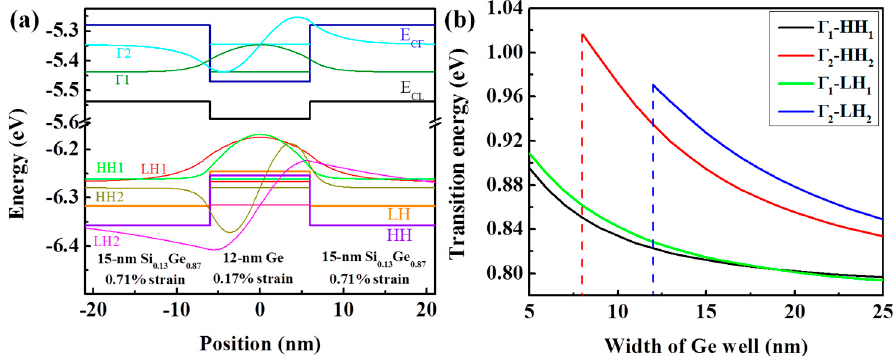
Figure 4. ( a ) Band alignment for a 15-nm Si 0.13 Ge 0.87 /12-nm Ge quantum well and corresponding electronic states; ( b ) Energy variation of Γ 1-HH1, Γ 2-HH2, Γ 1-LH1, and Γ 2-LH2 transitions versus the width of a Ge well. The strain in the Ge well and the SiGe barrier used for calculation is 0.17% and 0.71%, respectively.